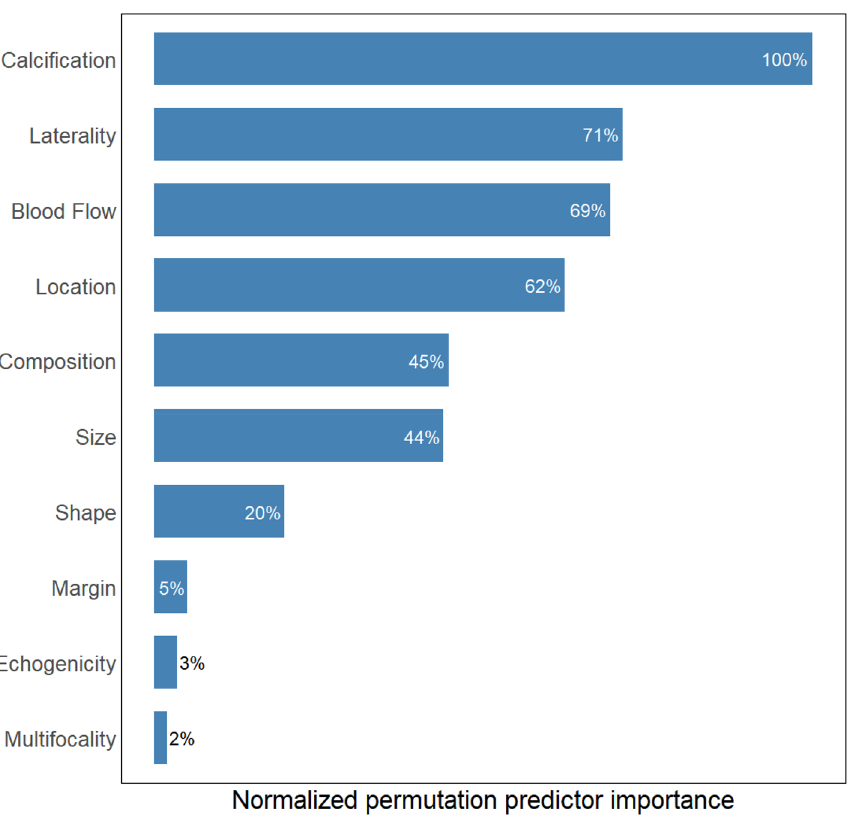
Figure 4. The normalized permutation predictor importance for the top ten variables. Variables are sorted from high to low based on their relative